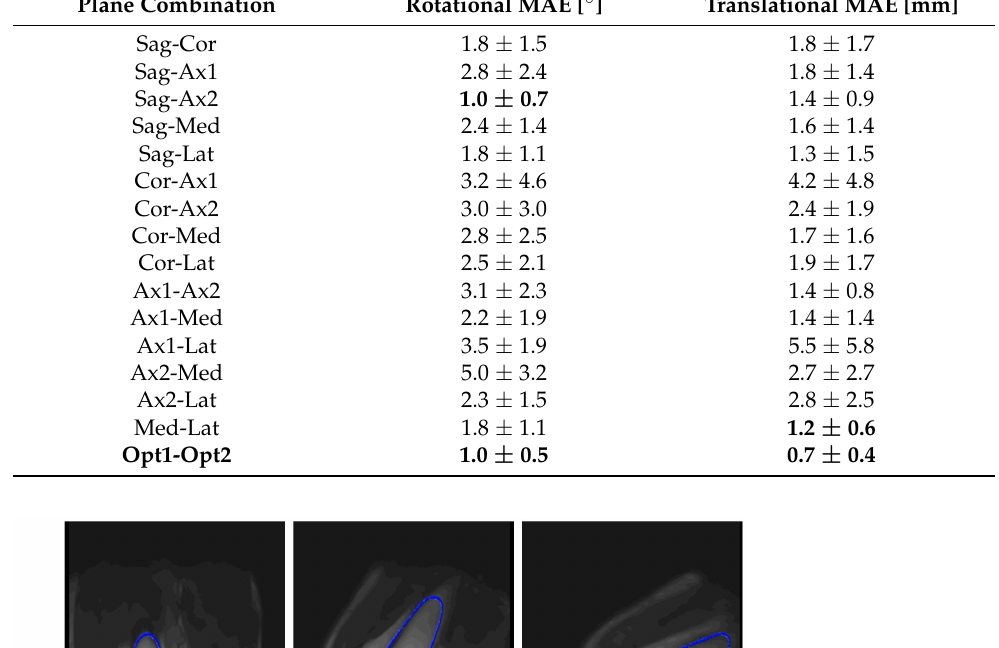
Table 1. Rotational and translational MAE for each of the tested combinations of DMRI planes.